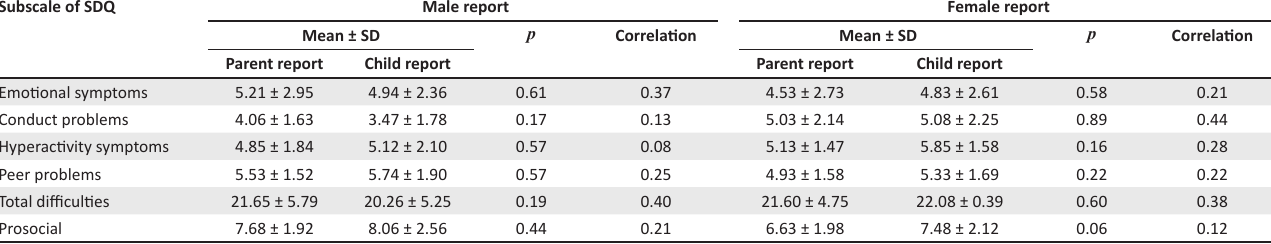
TABLE 1: The Strengths and Disabilities Questionnaire scores for boys and girls, and their parents. Subscale of SDQ